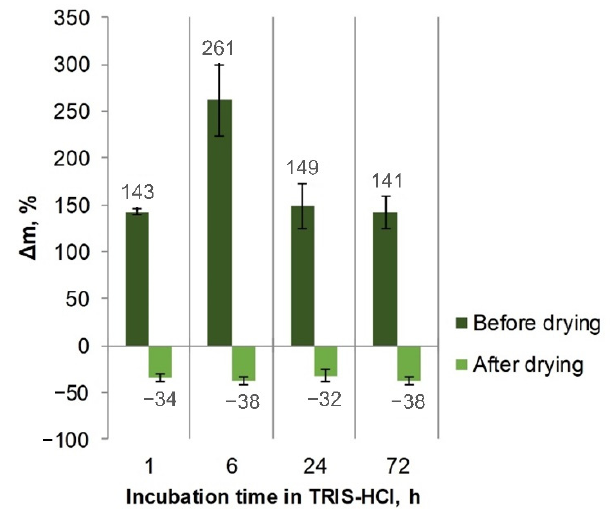
Figure 5. Mass changes of Ca-alginate hydrogel beads after incubation in TRIS-HCl buffer.